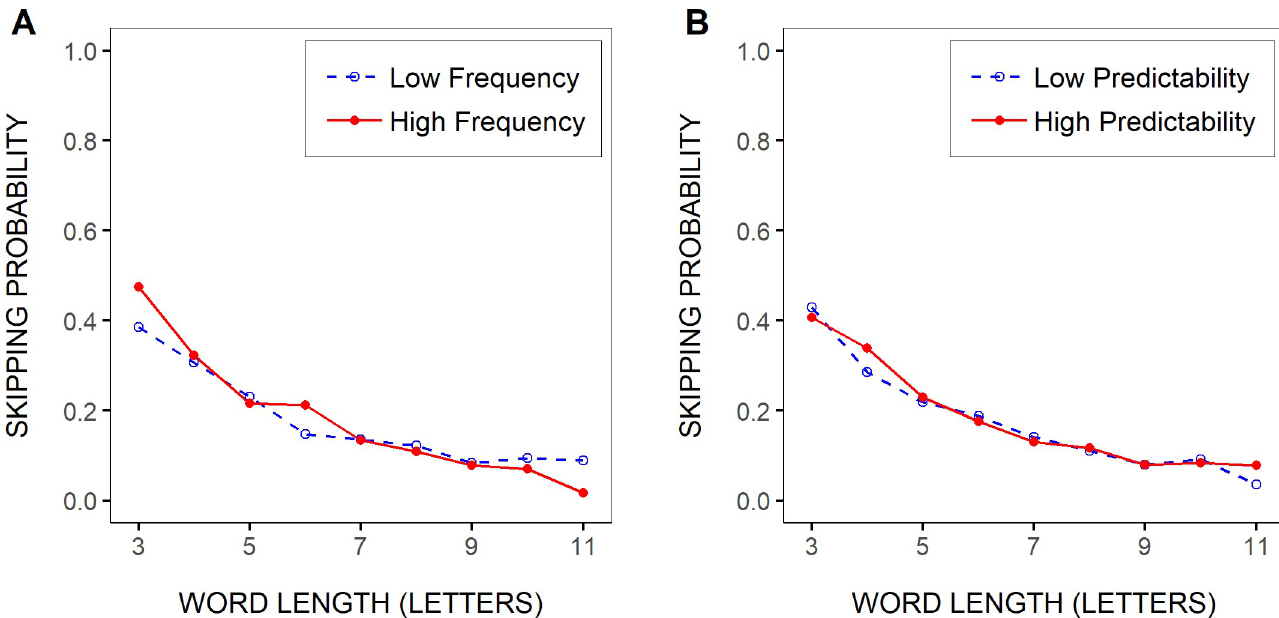
Fig 2. Test-word skipping rate by length, frequency and predictability. Mean probability of skipping the test words as a function of the words’ length (in letters), separately for two categories of test-word frequencies (A) and predictabilities (B), as determined after grouping test-word frequencies and predictabilities into two bins respectively (see Materials and